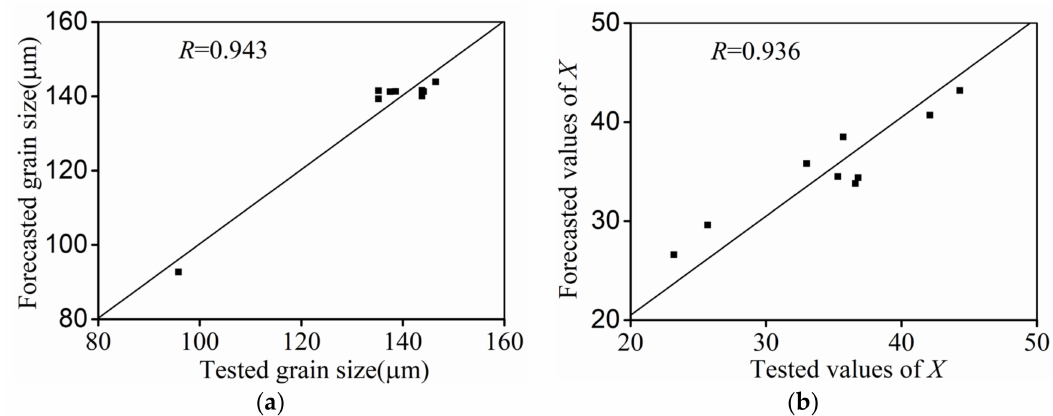
Figure 10. Comparison between forecasted and tested values of: ( a ) grain size, ( b ) X